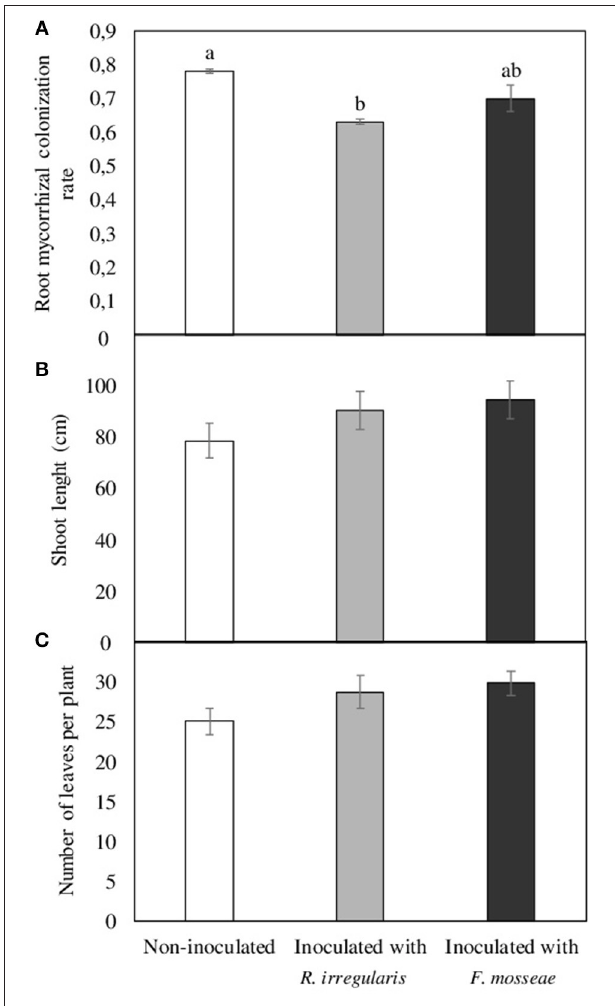
FIGURE 1 | (A) Root mycorrhizal colonization rate, (B) shoot length, and (C) number of leaves per plant in Touriga Nacional grapevine variety plants grafted onto 1103 Paulsen rootstock three months after inoculation and transplant to forest pot containers filled with sterile substrate. Data represent average values of three composite samples per treatment ± standard error in (A) , and 10 plants ± standard error in (B,C) . Different letters indicate significant differences among treatments according to Tukey b post-hoc tests at p ≤